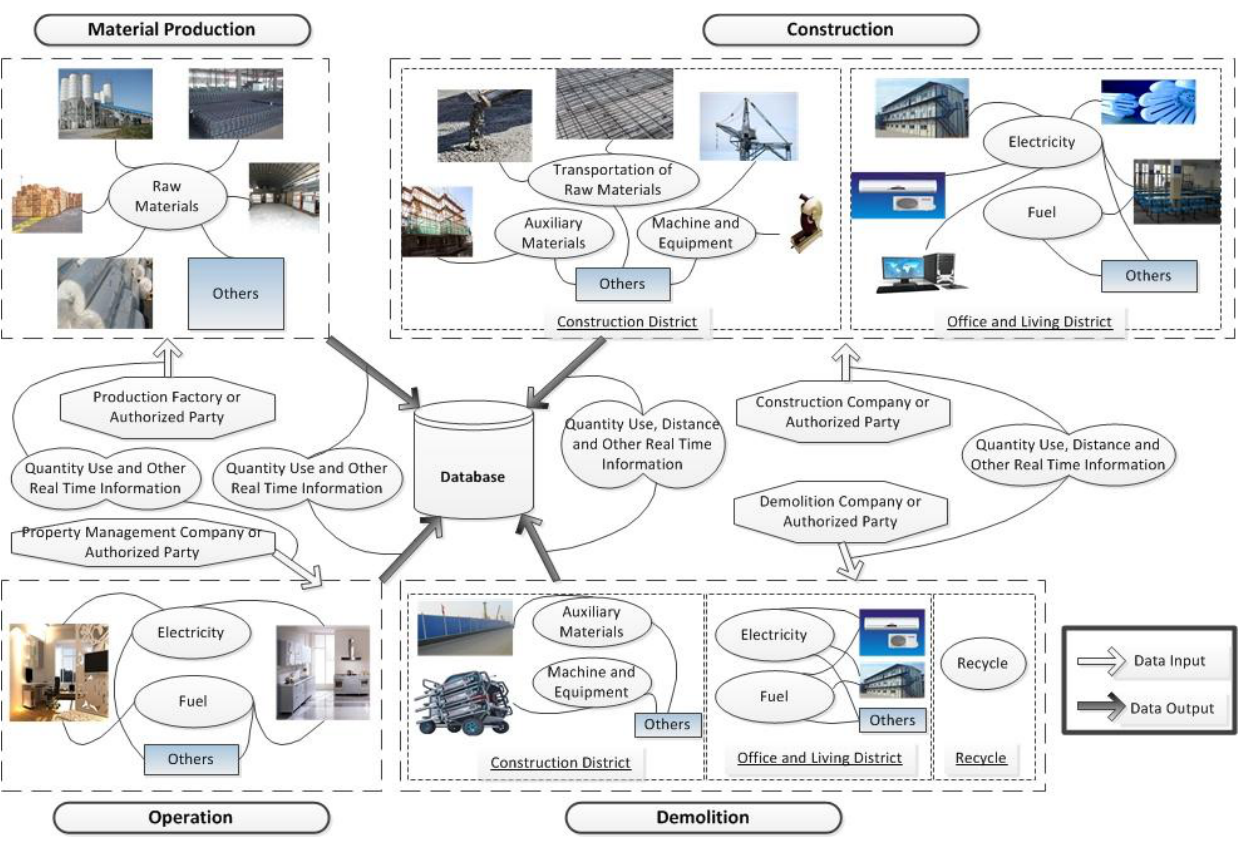
Figure 2. Model of data requirement for real-time